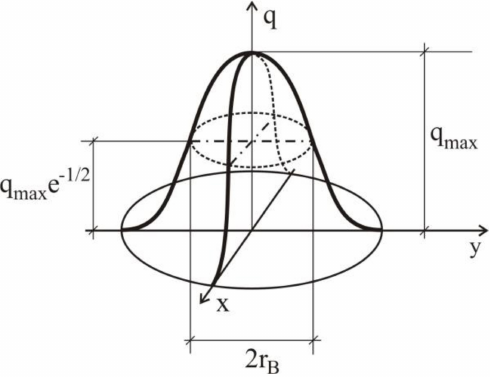
Figure 3. Gaussian model of heat